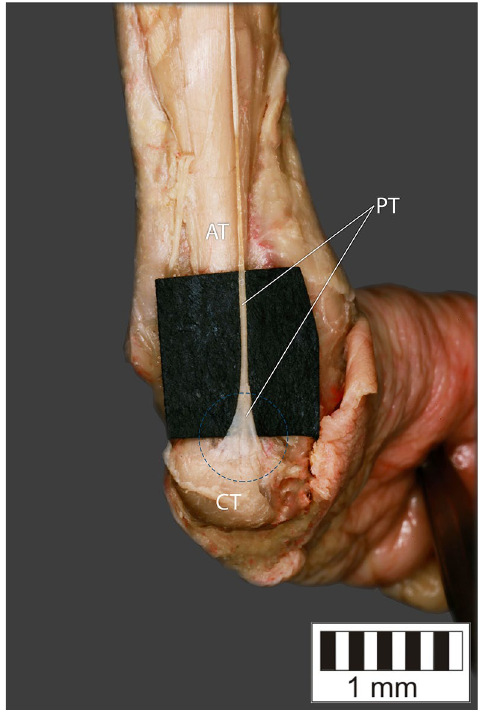
Figure 7. Type V of plantaris tendon. CT - calcaneal tuberostity, AT Achilles tendon, PT plantaris tendon.